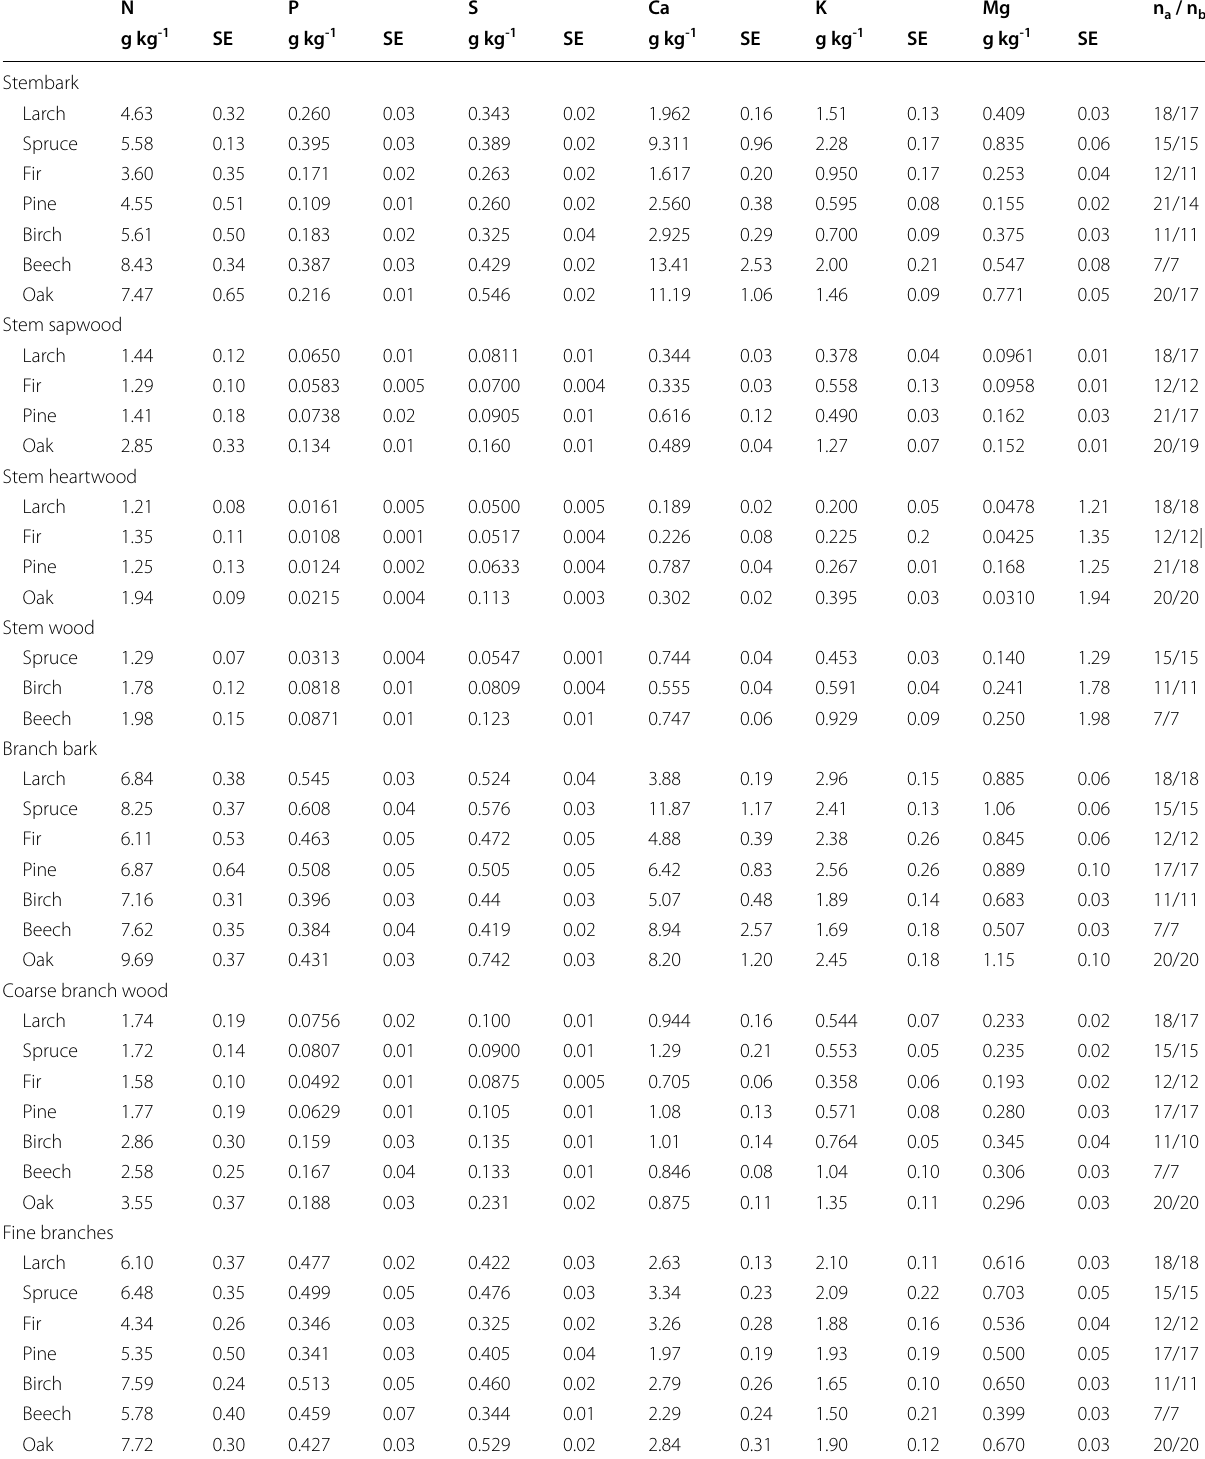
Table 1 Average concentrations (g kg -1 ) and standard errors (SE) of major nutrients in tree compartments of seven tree species with numbers of samples analysed for P, S, Ca, K and Mg (n sapwood and heartwood, and results are directly given as stem